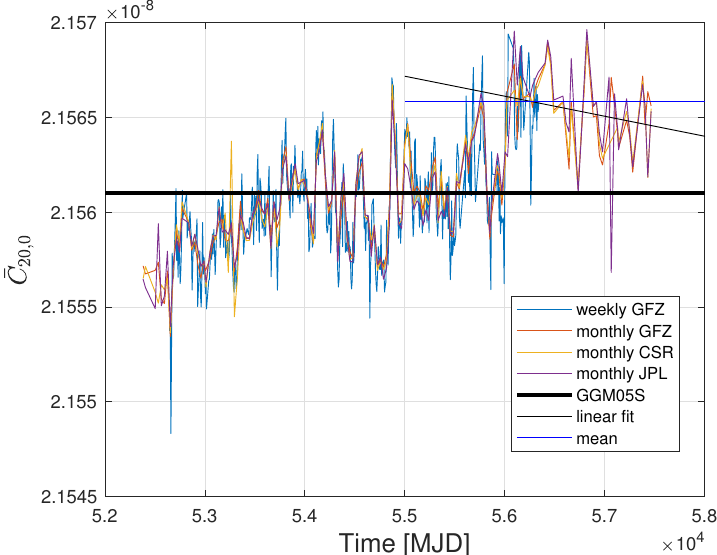
Figure 1. Time behavior for the normalised ¯ C 20,0 coefficient. The horizontal axis is in Modified Julian Date (MJD). The measurements obtained for the coefficient from GRACE data by three independent Analysis Centers are compared with the static value provided by the GGM05S solution (heavy black line) and with the mean value (blue) and the linear behavior (soft black line) that we computed for this coefficient in the time span of our new